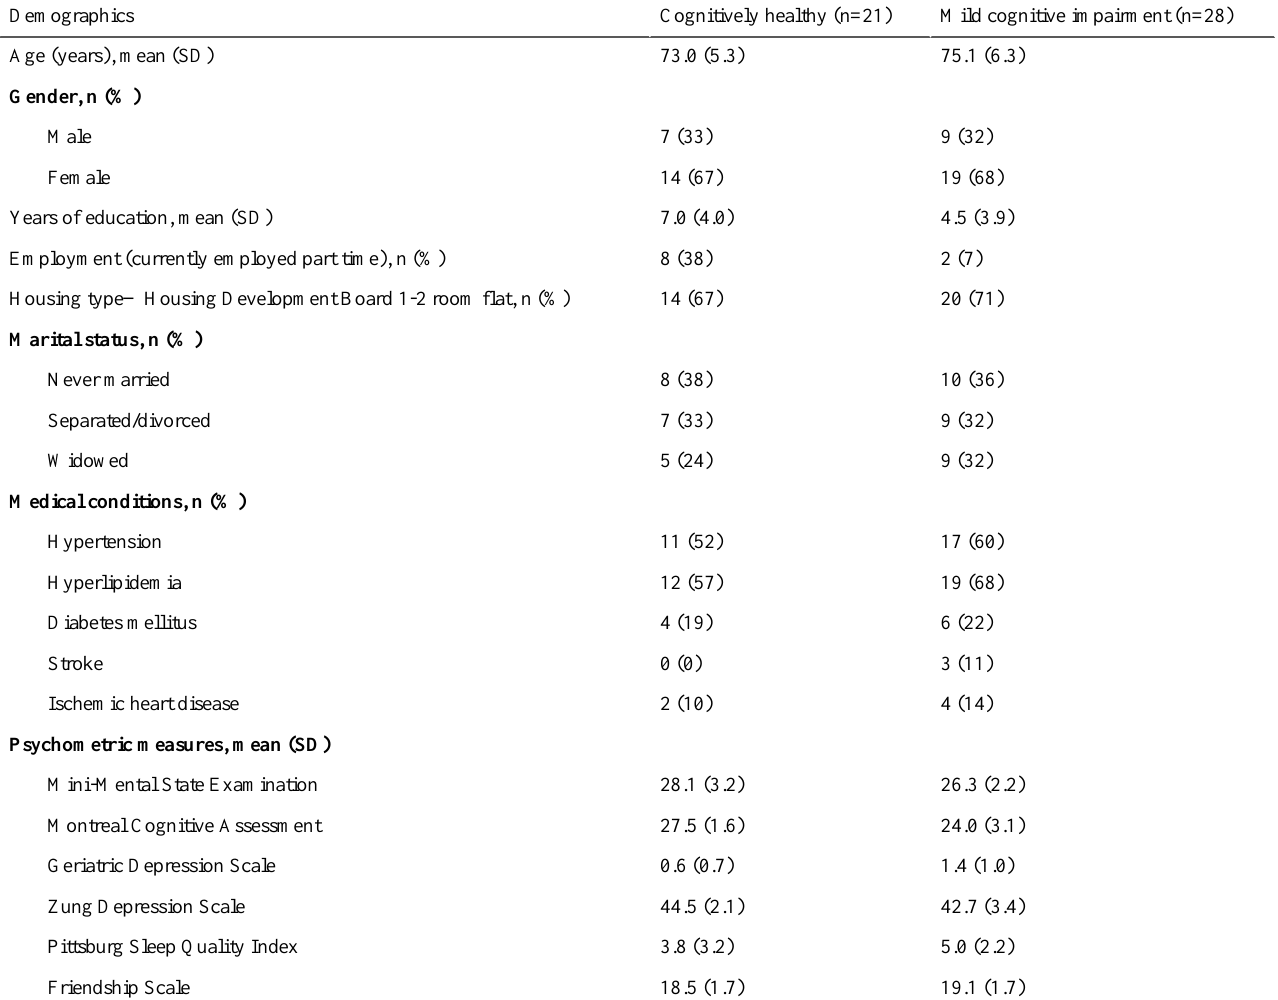
Table 1. Participant characteristics by group—normal cognition vs mild cognitive